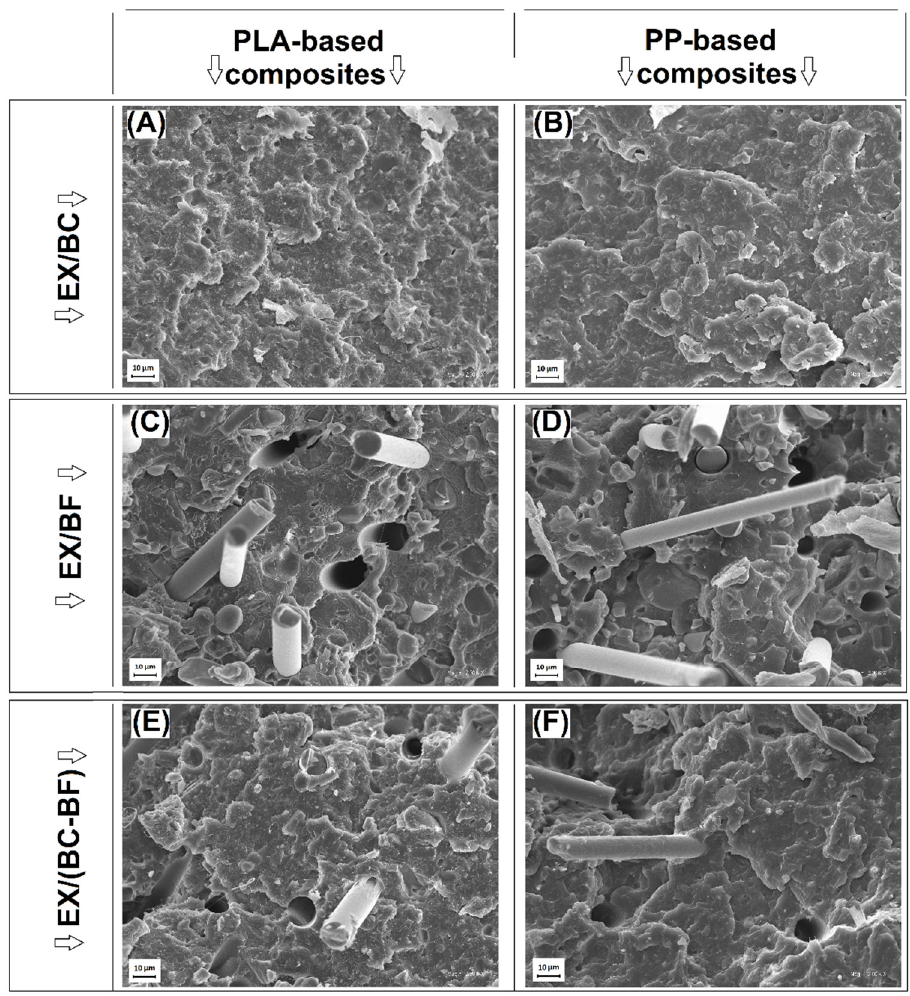
Figure 2. The structure appearance of the hybrid samples: ( A , B ) EX/BC, ( C , D ) EX/BF, and ( E , F ) EX/(BC-BF).